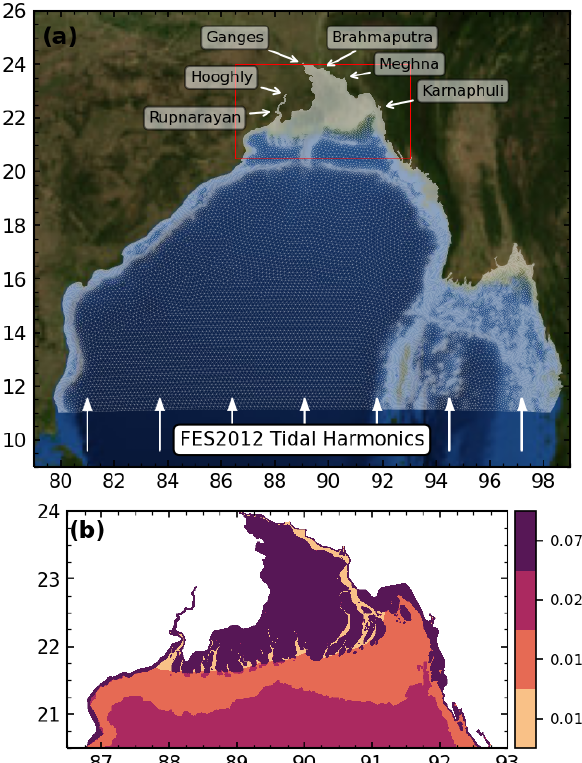
Figure 2. (a) Model domain with arrows indicating the open bound- aries. (b) Distribution of Manning coefficient. The background used in (a) is taken from Blue Marble: Next Generation, credited to NASA Earth